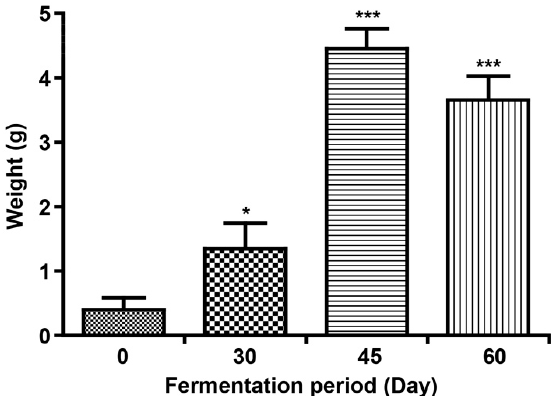
Figure 2. Effect of fermentation period [unfermented sawdust (0), 30-day fermented sawdust (30), 45-day fermented oak tree sawdust (45), and 60-day fermented oak tree sawdust (60)] on seedling weight. Each fermentation period was statistically compared with 0 day. The asterisks indicate significant difference (* p < 0.05 and *** p < 0.001).